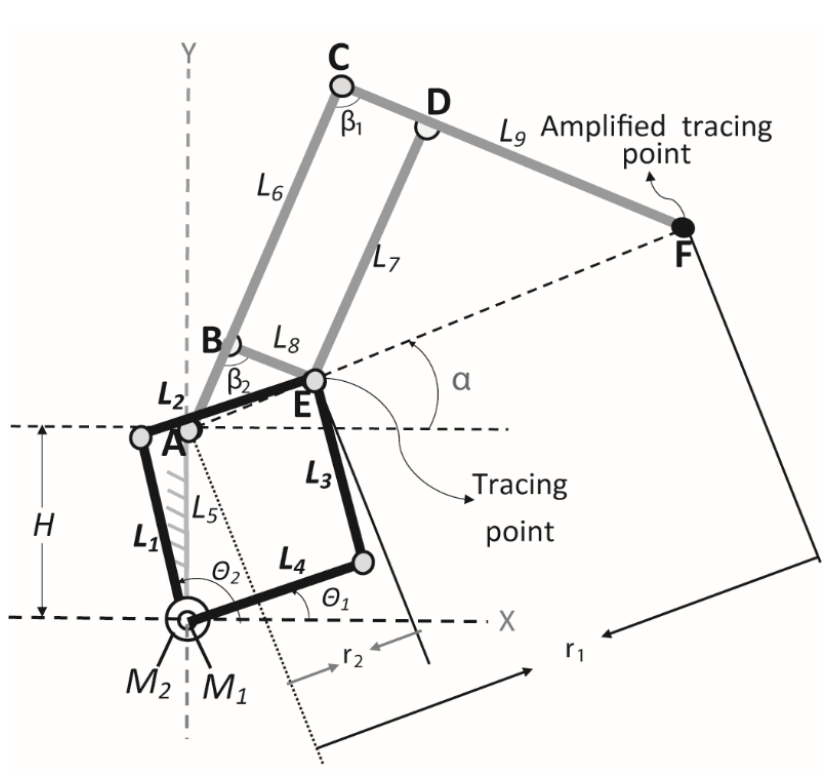
Figure 5. Kinematic diagram of Nurse with motion and design parameters [25].